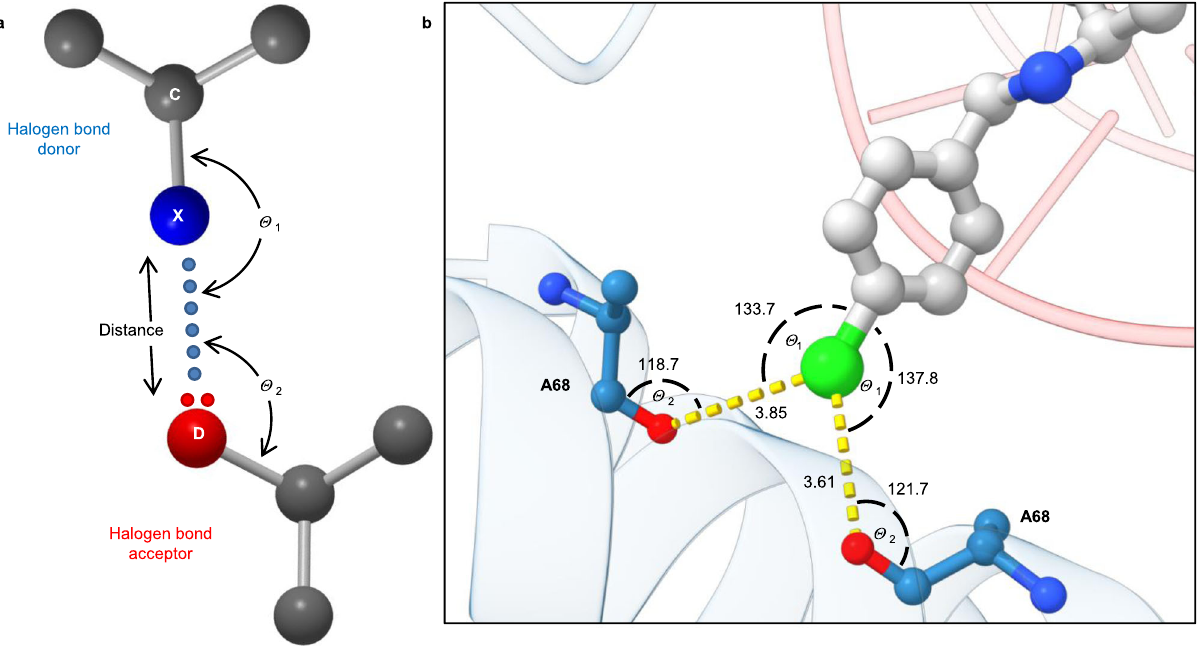
Fig. 7 Halogen bonding. a Classical interpretation of halogen bonding involves a linear interaction, as de fi ned by θ 1 and θ 2 angles — especially the θ 2 angle, which depends on the nature of the heteroatom. b Halogen bonding in crystal complex of 4 (balls and sticks representation colour coded by element) with S. aureus gyrase (represented as cartoon in blue) and oligonucleotide (represented as cartoon in red). Ala68 are in balls and sticks representation colour coded by element.